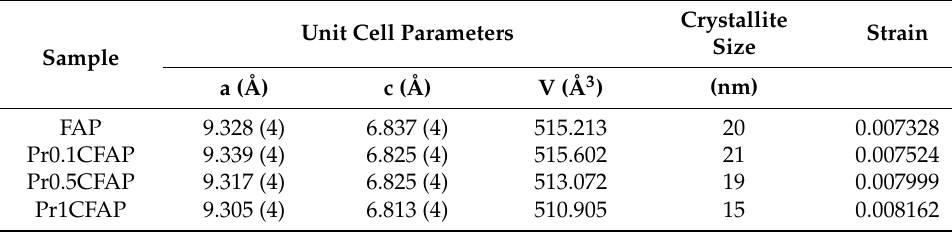
Figure 1. XRD patterns of the FAP and Pr x CFAP samples. Table 1. Unit cell parameters, crystallite size and strain of FAP and PrxCFAP